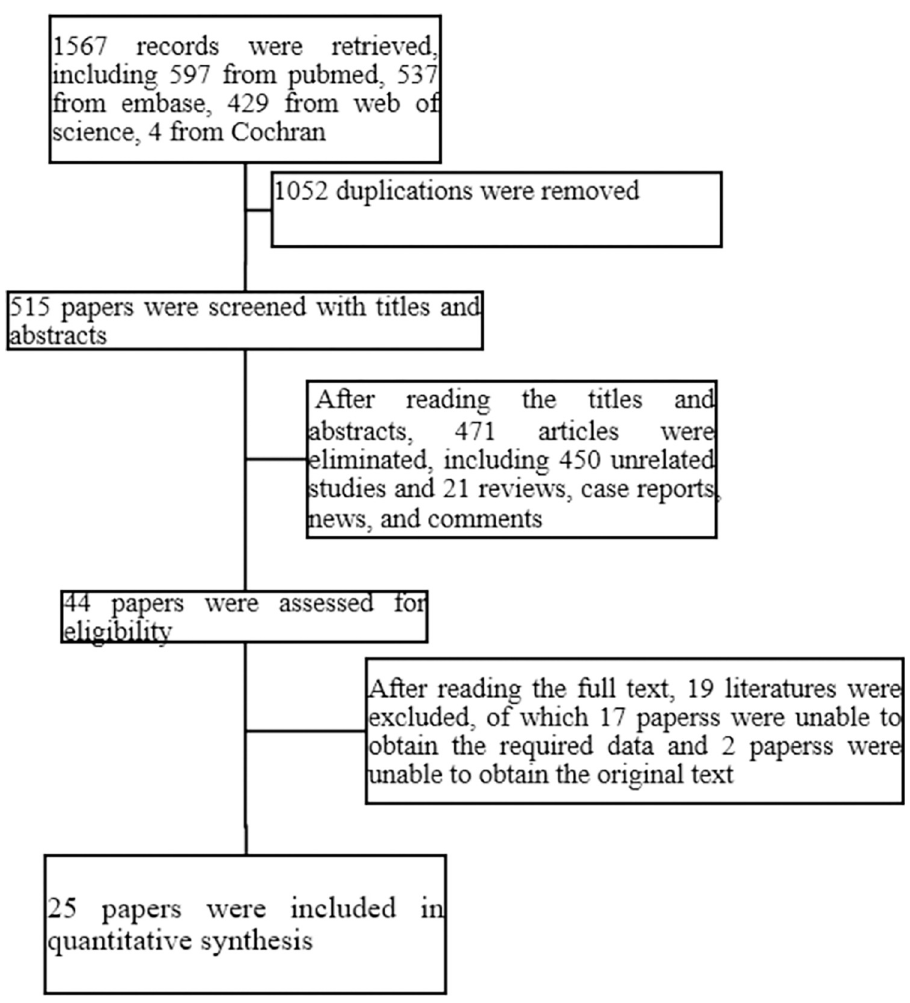
Fig 1. Flow diagram of the study selection